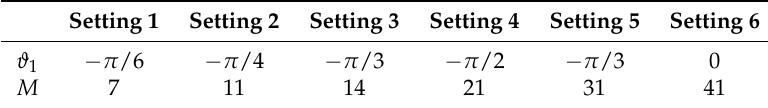
Table 1. After the calculation of far-field pattern data, a 20 dB white Gaussian random noise is added to the unperturbed data. Table 1. Test configuration for observation